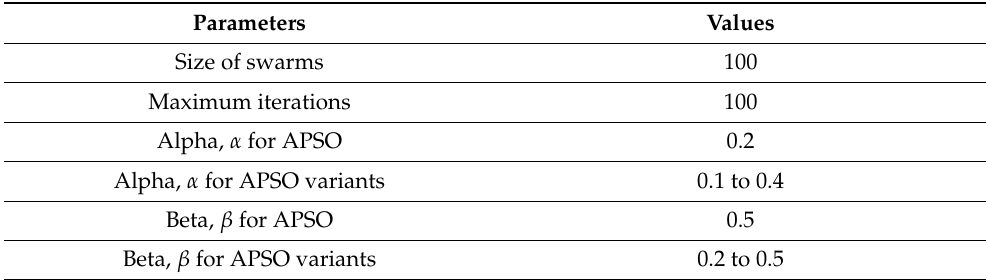
Table 2. Parameters for APSO and its